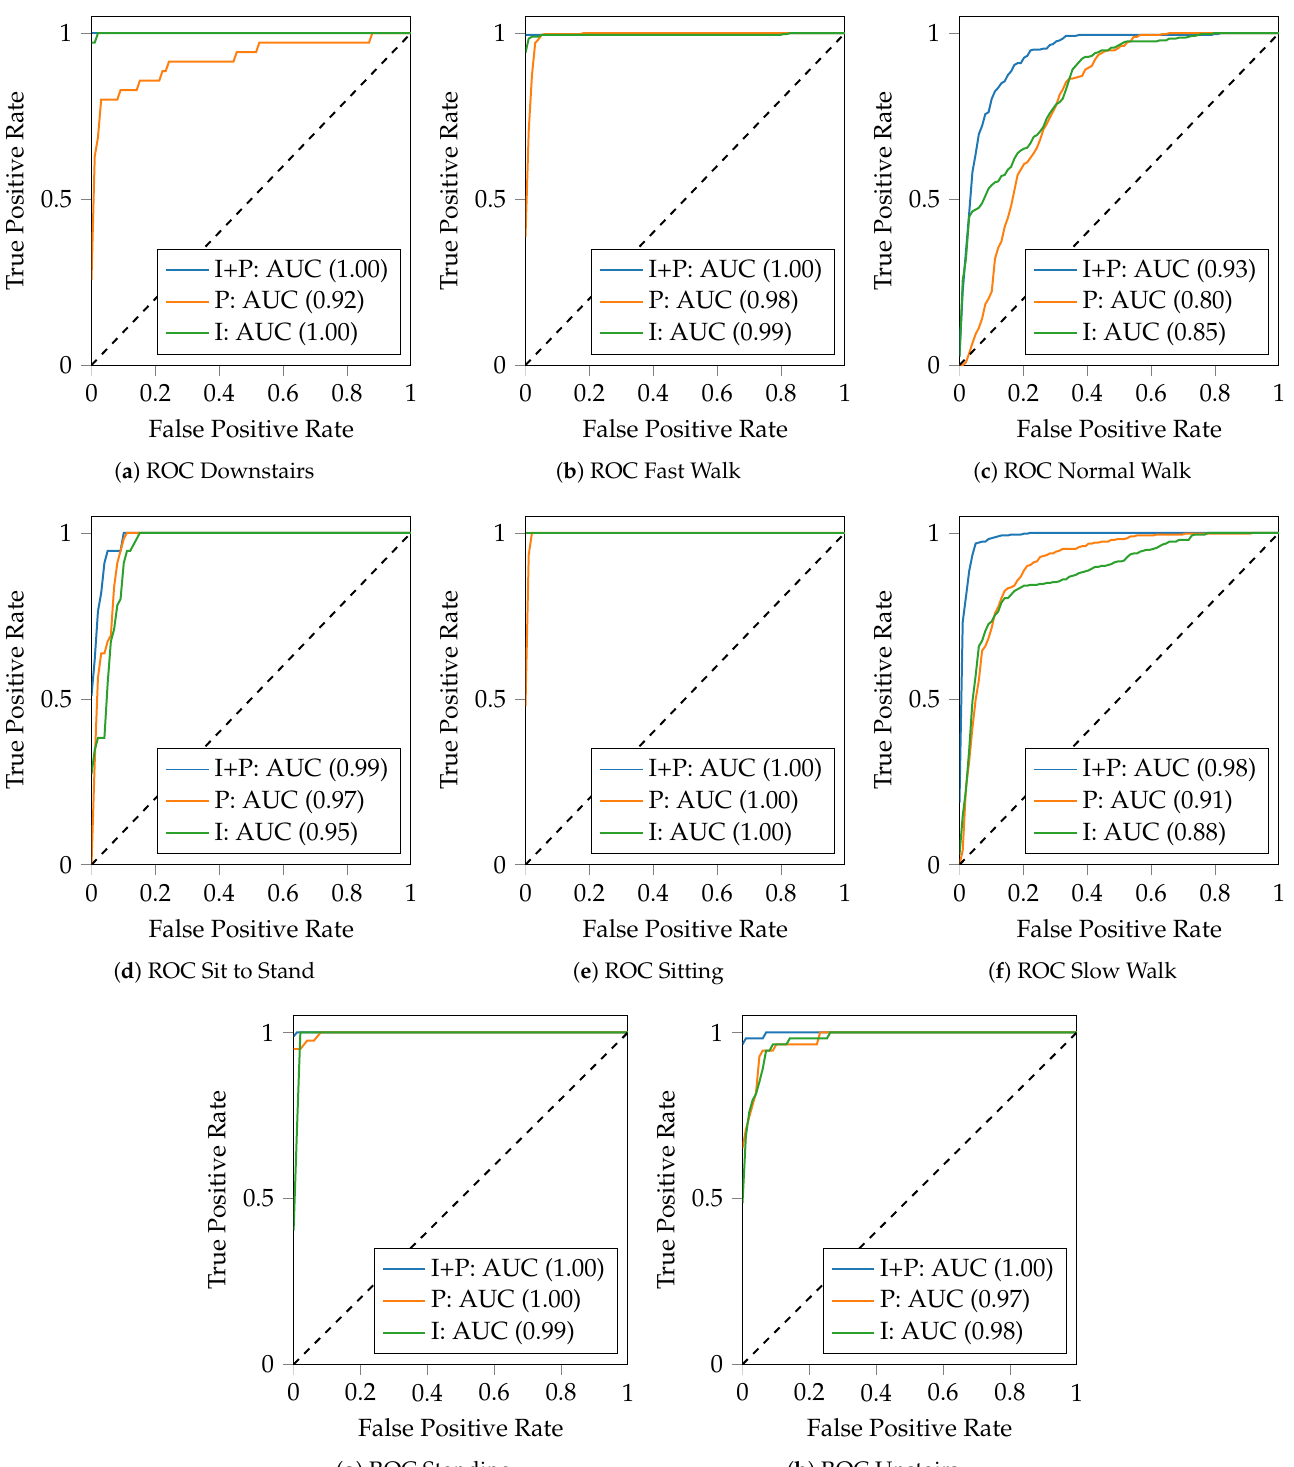
Figure 3. Evaluation of ROC curves for each activity using three different datasets built from different types of sensors: Inertial sensors and pressure sensors (I + P), pressure sensors (P), and inertial sensors (I). In ( e ), since the sitting activity is correctly classified in all the experiments, the curve “I+P: AUC (1.00)” overlaps “I: AUC (1.00)” and is not